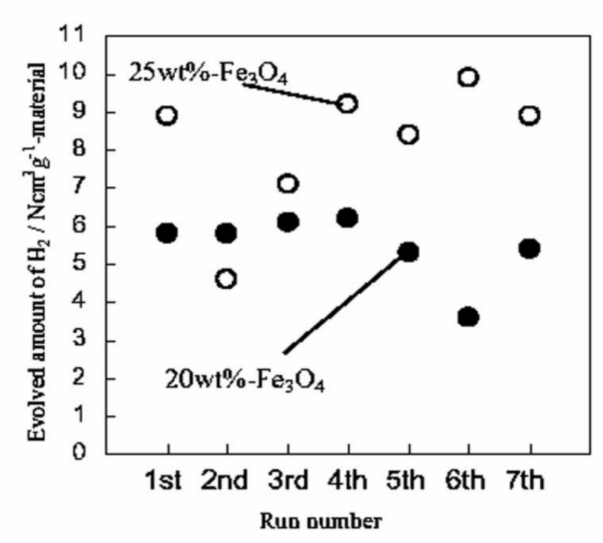
Figure 12. Evolved amount of hydrogen as a function of the run number for Fe 3 O 4 supported on yttrium-stabilized zirconia. The reduction temperature was 1400 ◦ C. The solid circles represent 20 wt%-Fe 3 O 4 and the open circles represent 25 wt%-Fe 3 O 4 . Reprinted from [30].